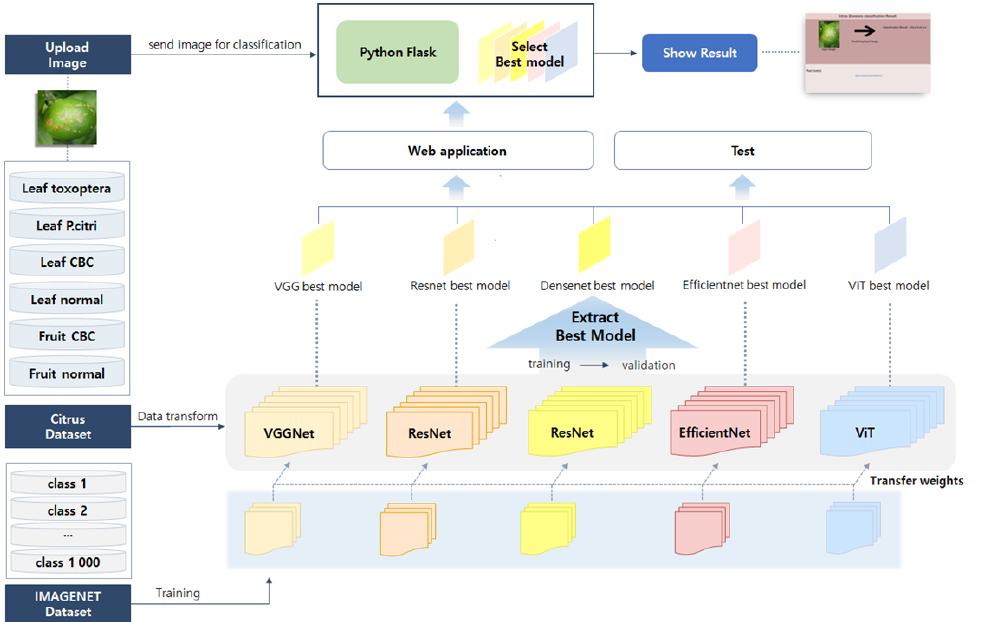
Figure 1. Citrus pest classification system network